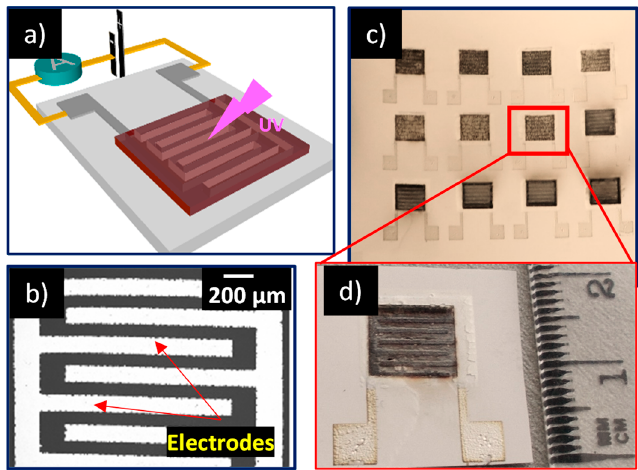
Figure 1. ( a ) Process sequence for fabrication of the paper-based devices; ( b ) SEM (Scanning electron microscope) image of the silver interdigitated electrodes; ( c , d ) Optical images of laser sintered devices fabricated on a paper substrate.